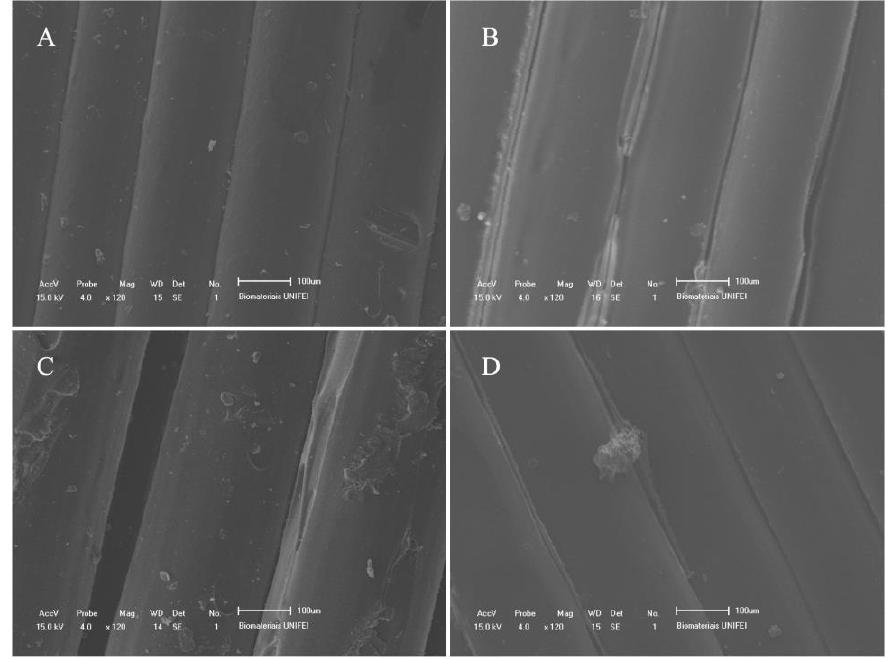
Figure 1. SEM of polymer samples for ( A ) ABS exposed to water; ( B ) TPU exposed to sweat; ( C ) TPU exposed to alcohol and ( D ) PLA exposed to soap.